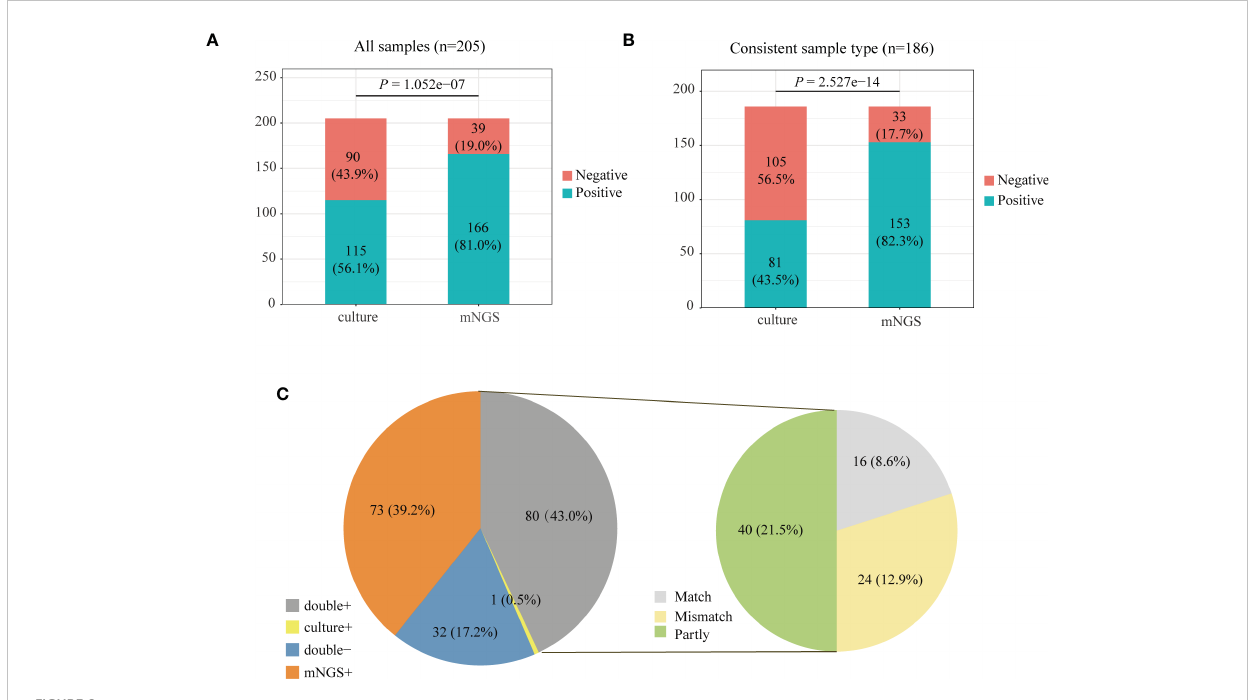
FIGURE 2 Positive rate comparison between metagenomic next-generation sequencing (mNGS) and laboratory culture for 205 community-acquired pneumonia (CAP) patients (A) and 186 pneumonia patients whose sample type was consistent for mNGS and culture (B) . (C) The positivity distribution of mNGS and culture for 186 patients with a consistent sample type. For the double-positive subgroup, the cases were divided into matched, mismatched, and partly matched groups based on the consistency of pathogens detected by the two methods.